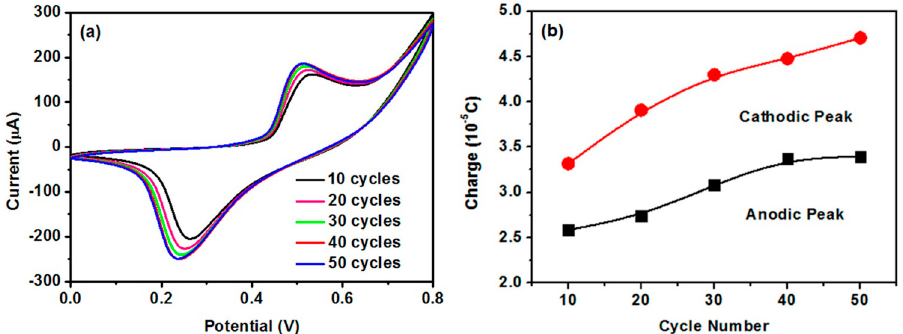
Figure 3. ( a ) CVs of CeO 2 /Ni(OH) 2 /CPE after 10, 20, 30, 40, and 50 consecutive cycles in 0.1 M NaOH solution at 50 mV/s scan rate; ( b ) Plots of charges integrated from anodic and cathodic peaks in CVs versus number of cycles.